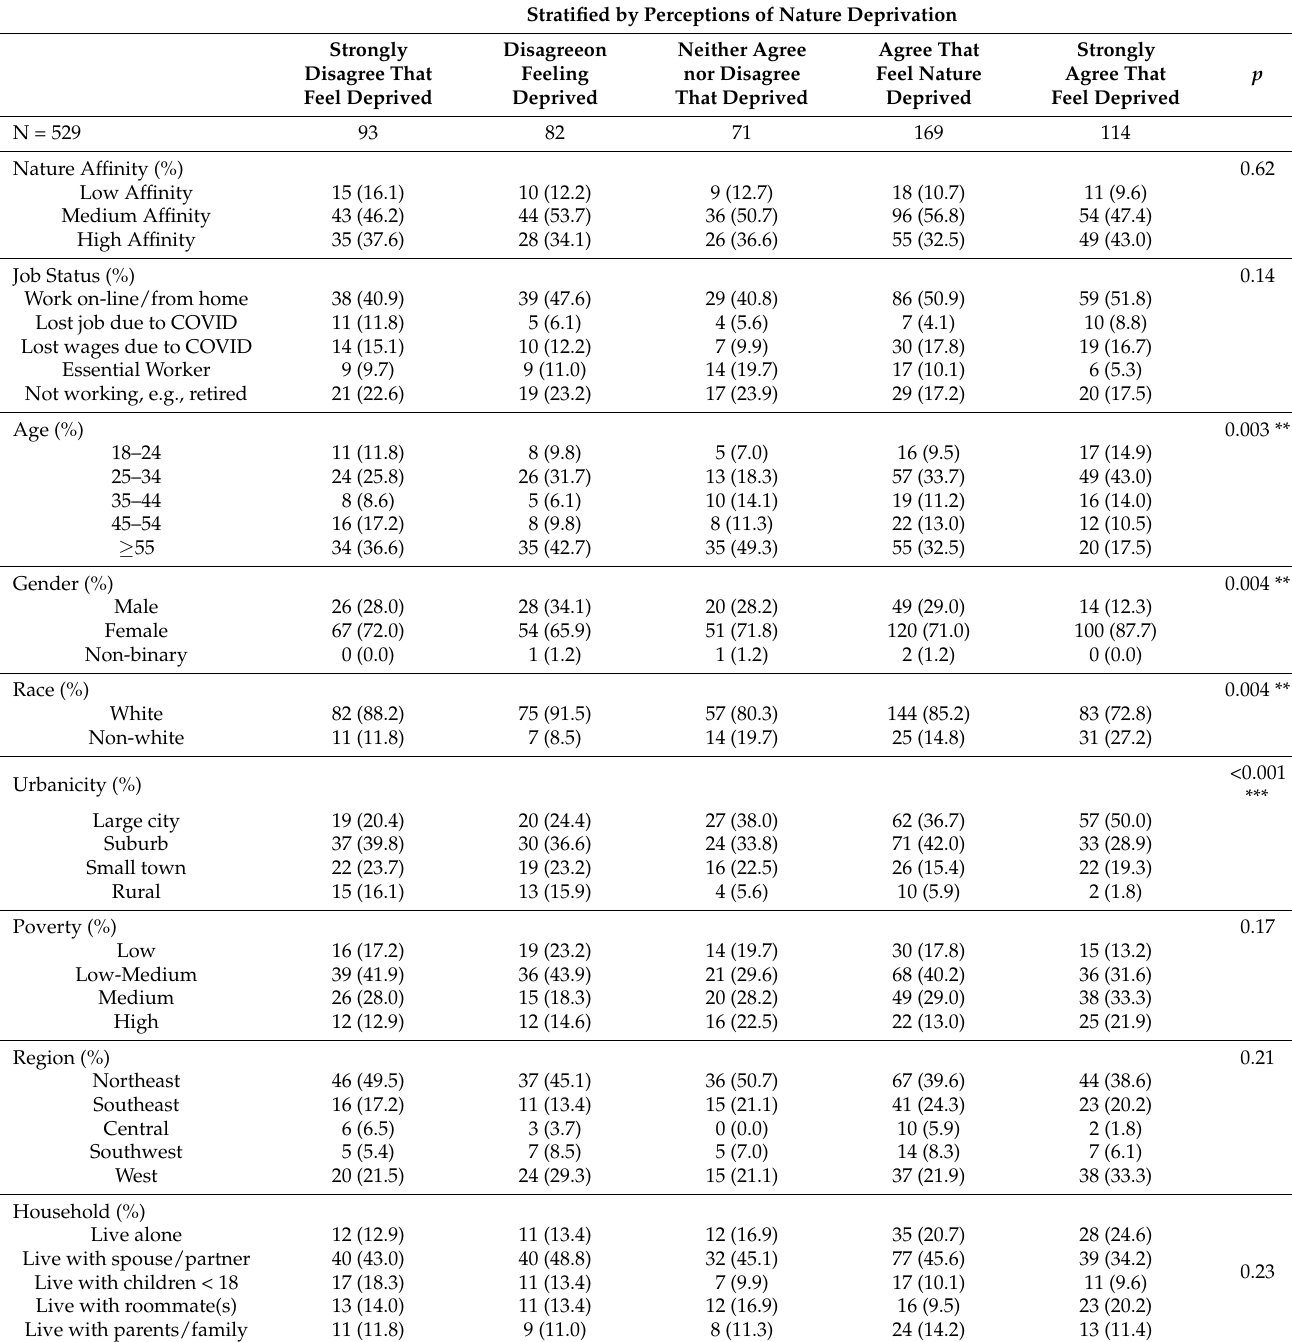
Table 1. Characteristics of the survey study population (N (% total)). p values indicate level of significance for a univariate test for differences in each variable across